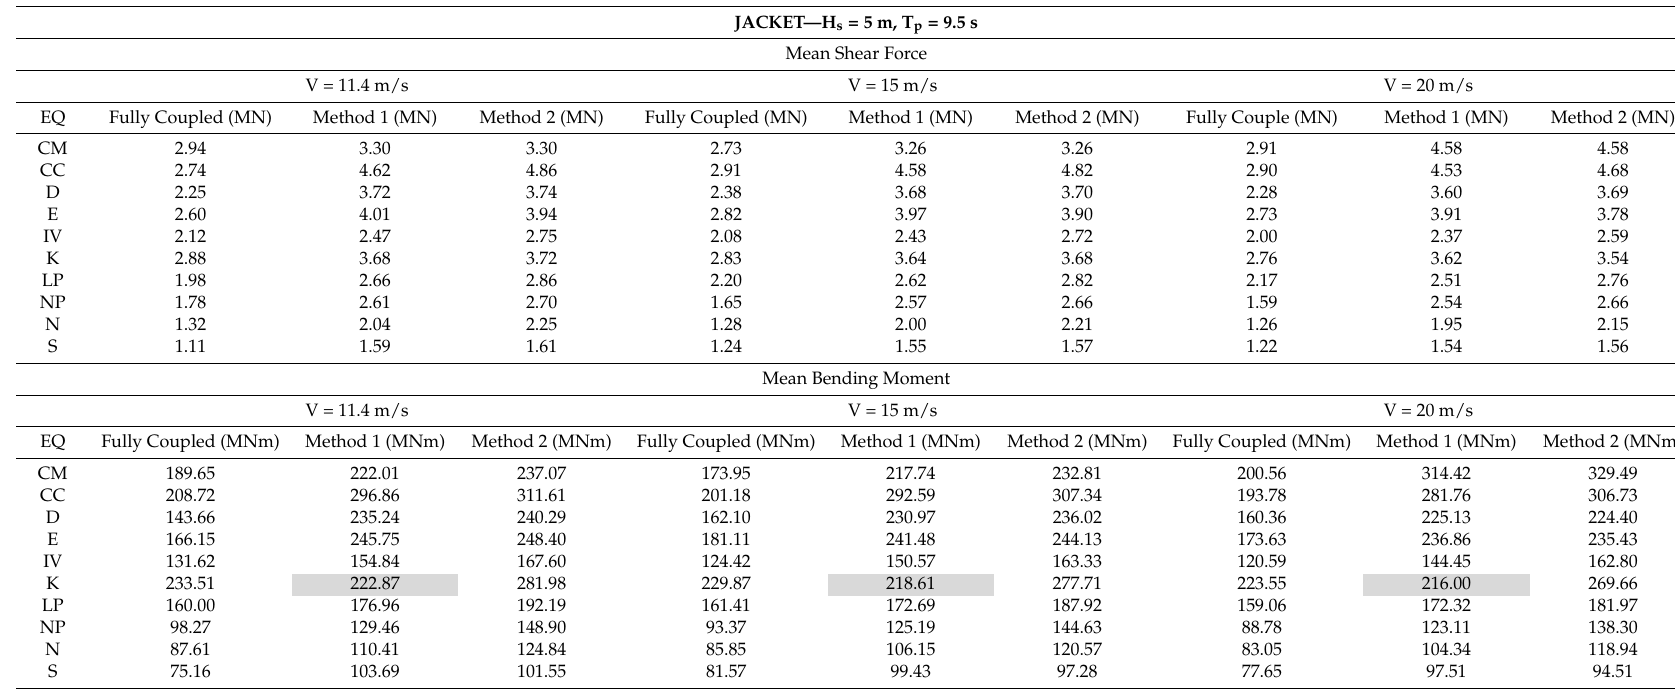
Table 4. Jacket: Mean shear-force and bending-moment demands at tower base, obtained by Methods 1-2 for sea state parameters H s = 5 m, T p = 9.5 s, all wind velocities and earthquake records listed in Table